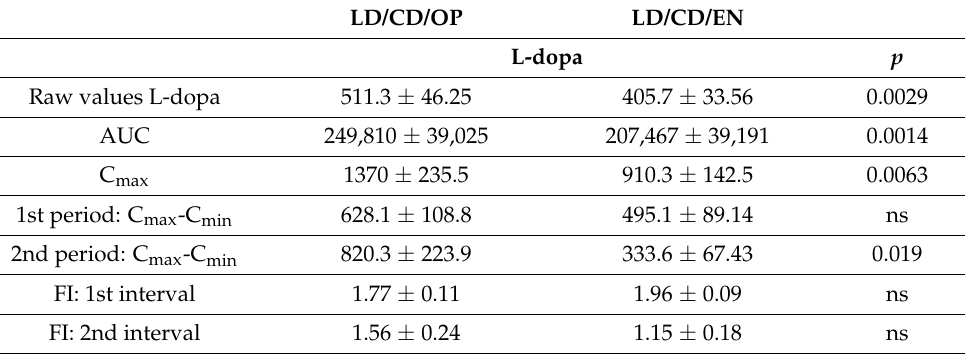
Table 2. Comparison between both conditions. AUC, area under the curve; AUC UPDRS III;